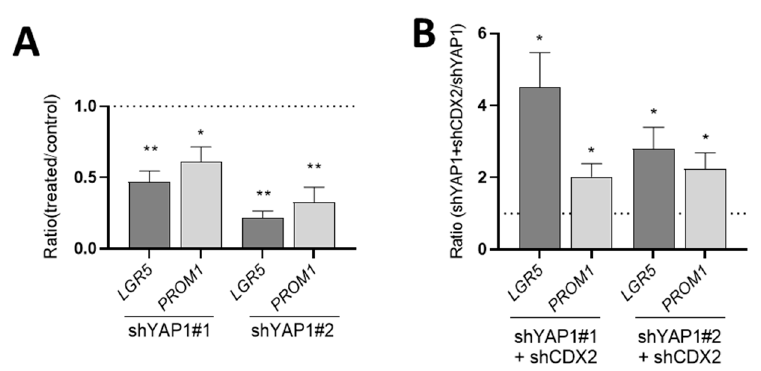
Figure 13. Abolition of CDX2 expression restores control LGR5 and PROM1 levels in five-days post-confluent shYAP1 cells. ( A ) qPCR analysis showing that the abolition of YAP1 resulted in a significant reduction of LGR5 and PROM1 expression. ( B ) qPCR analysis showing that the abolition of CDX2 in shYAP1 cells resulted in a significant increase in LGR5 and PROM1 expression relative to shYAP1 control cells. A: * significant vs. shCtrl, B: * significant vs. shYAP1; * p < 0.05, ** p < 0.005.